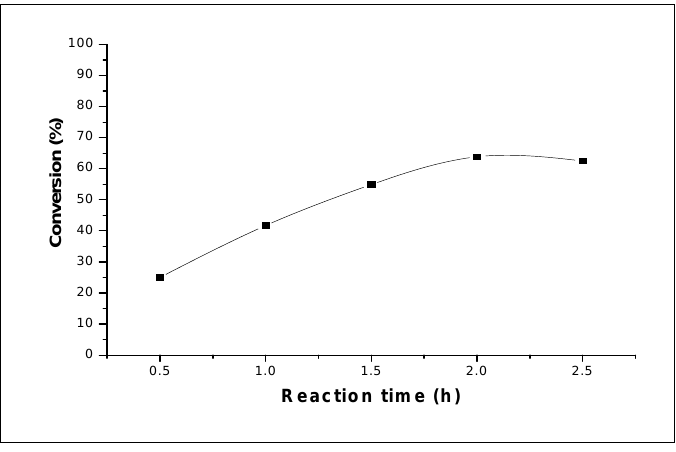
Figure 4. Influence of the reaction time on the conversion of THF catalyzed by 0.1 g